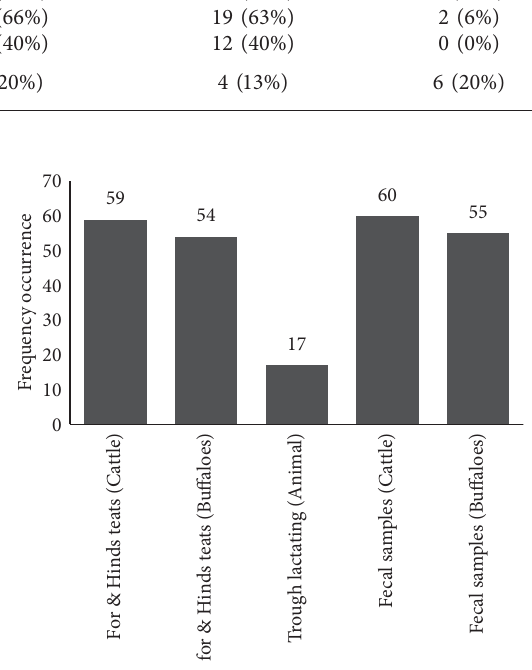
Figure 1: Frequency of occurrence isolates from different sampling point percentages.